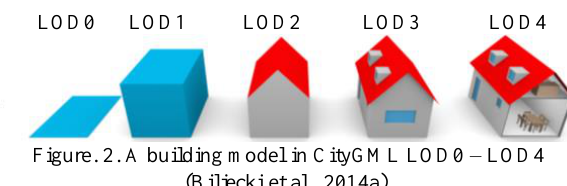
Figure. 2. A building model in CityGML LOD0 – LOD4 (Biljecki et al.,